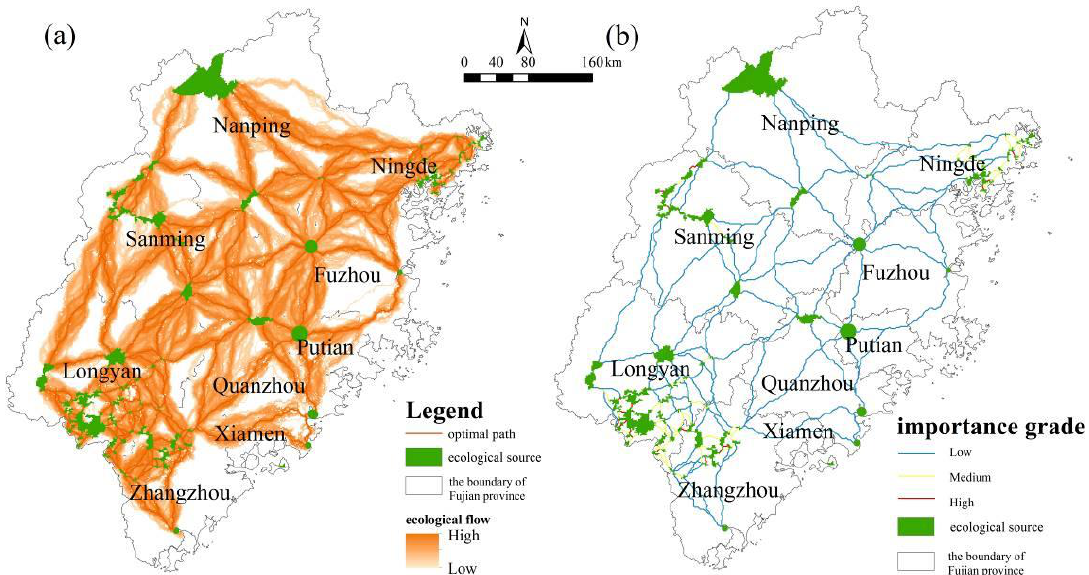
Figure 6. Identification of ecological corridors and assessment results of their importance in Fujian. ( a ) the spatial distribution of ecological corridors and ( b ) importance grade of ecological corridors.